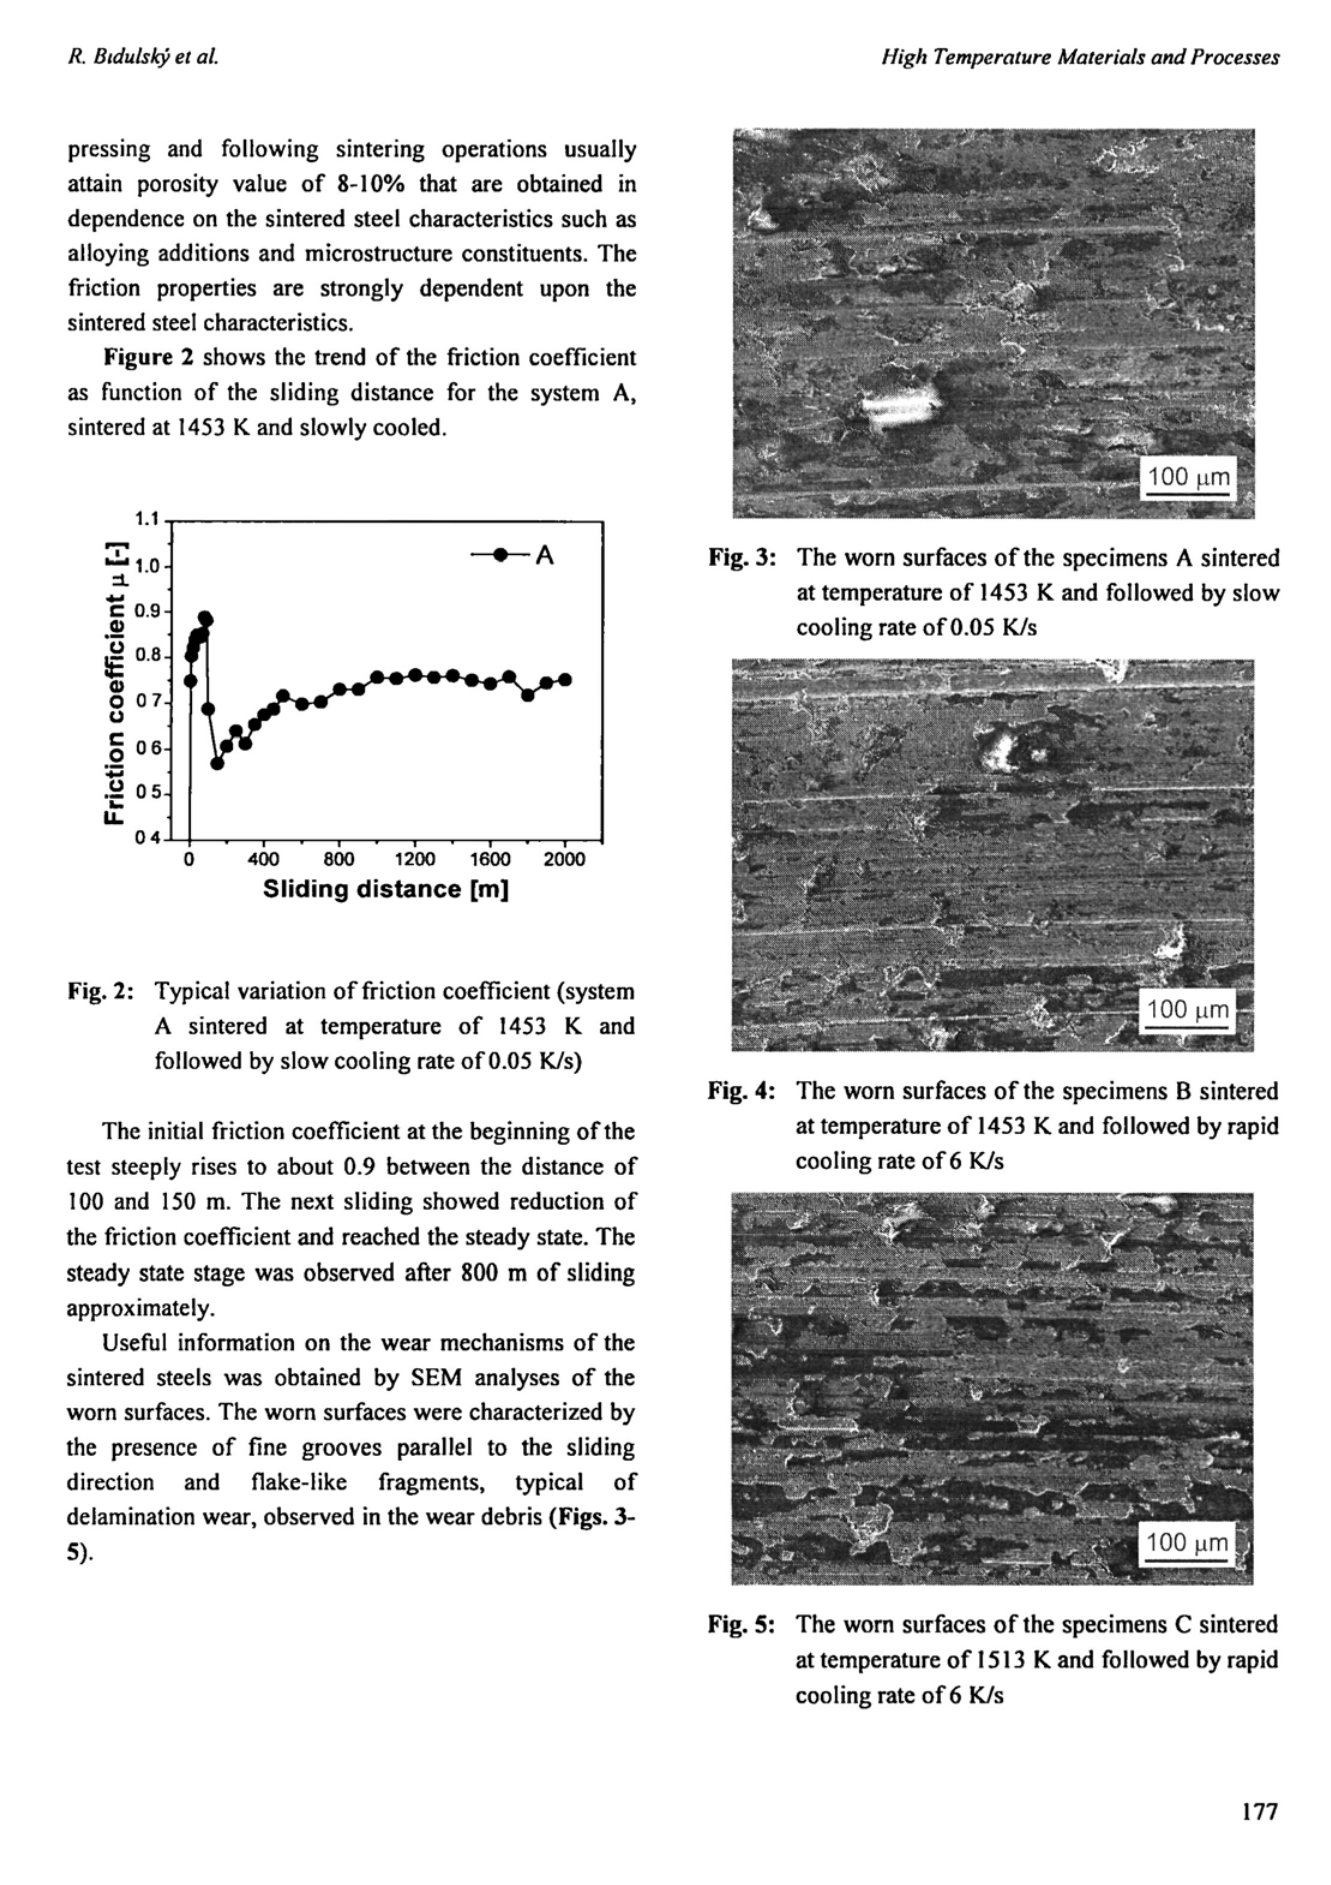
Fig. 5: The worn surfaces of the specimens C sintered at temperature of 1513 K and followed by rapid cooling rate of 6 K/s